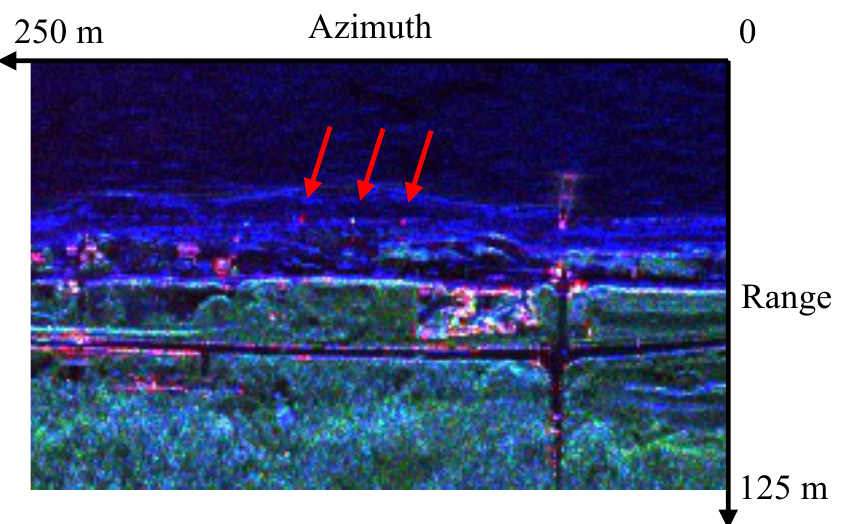
Figure 5. Scattering power decomposition image with corner reflectors on a beach near Niigata Univ. on 21 August 2014 (Center: N37.881,